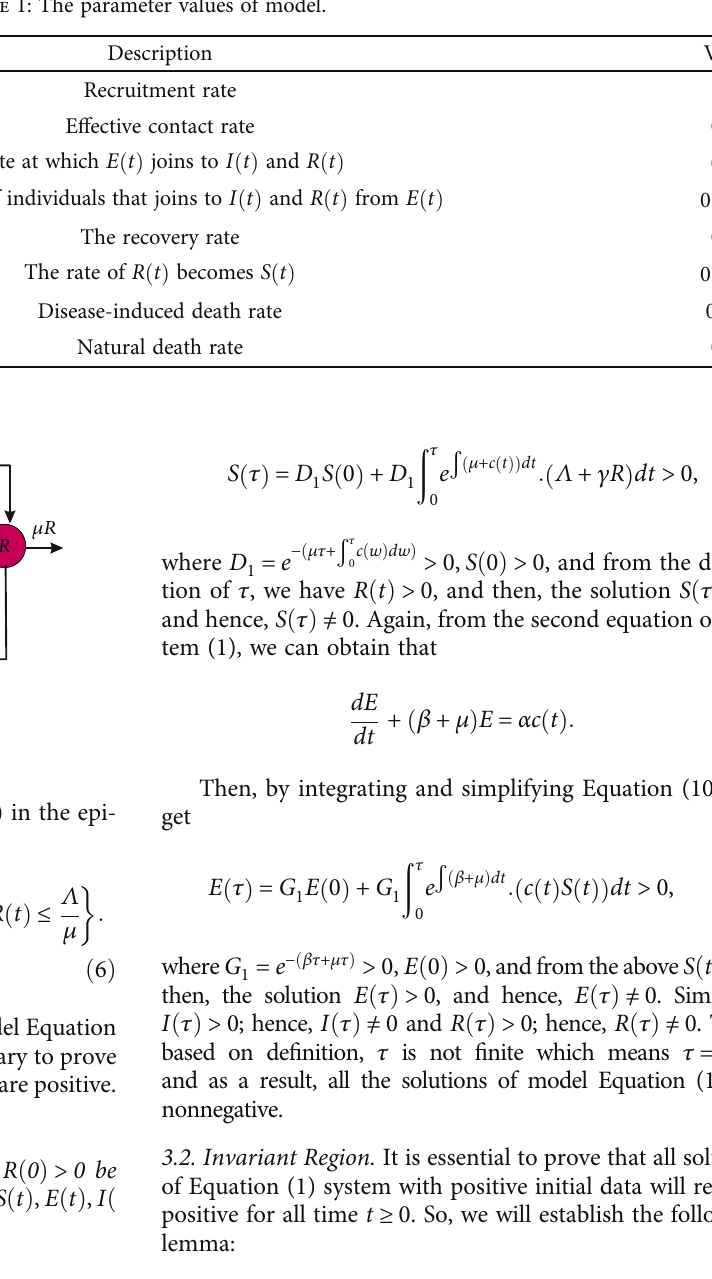
Table 1: The parameter values of model.